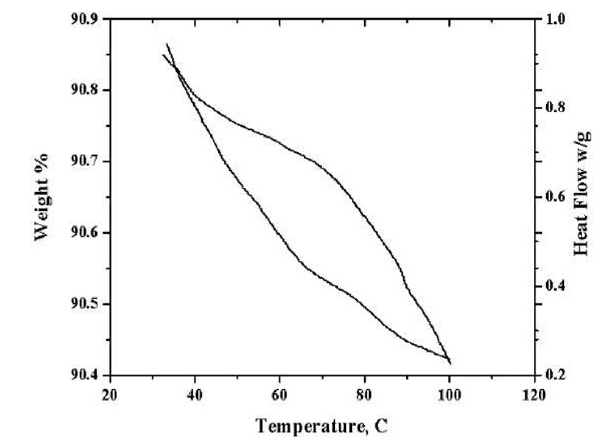
FIG. 3. DSC CURVE OF UN-AGED